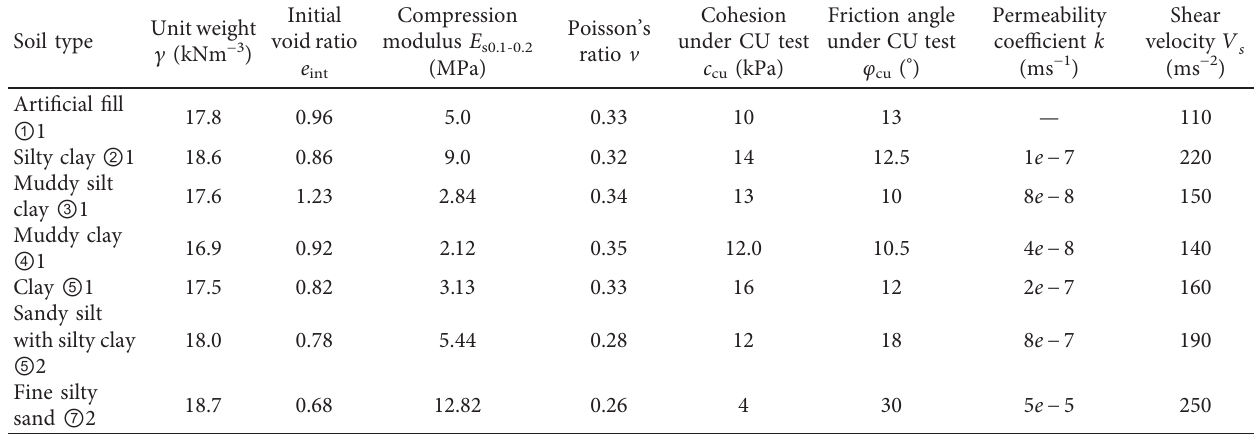
Table 1: Physical parameters of the soil layers.